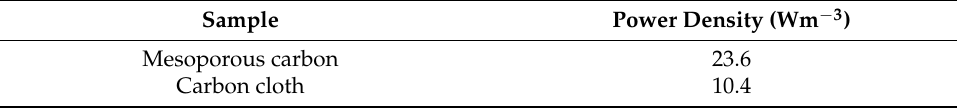
Table 6. Power density of microbial fuel cells with different